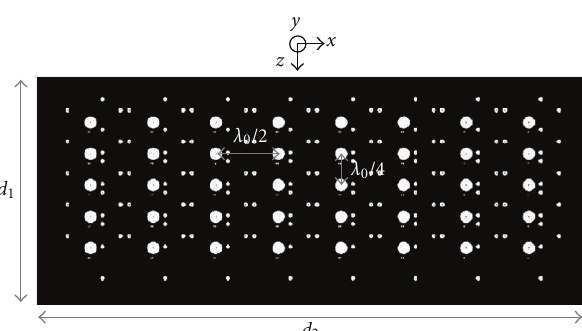
Figure 2: Printed dipole antenna.